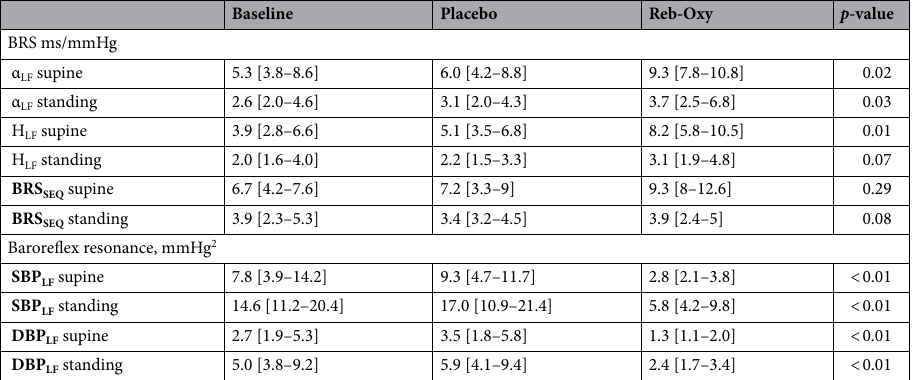
Table 4. Baroreflex sensitivity and resonance at baseline, on placebo, and on reb-oxy (n = 16). BRS: baroreflex sensitivity; SBP = systolic blood pressure; DBP = diastolic blood pressure; LF = low frequency; HLF = BRS estimation by transfer function technique in LF band and α LF = BRS estimation by spectral method in LF band (for further details, see methods). Data are expressed as percentage or median [interquartile]. P values compare placebo versus reb-oxy. P -values are calculated by comparing the percent changes from baseline observed after placebo versus reb-oxy.